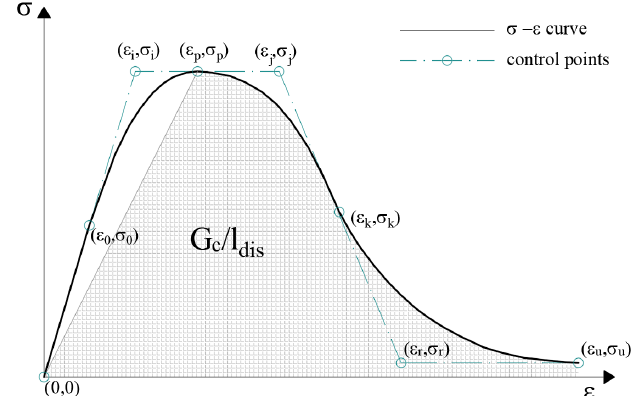
Figure 2. Uniaxial compression laws.